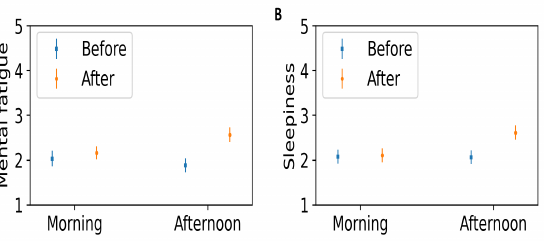
Figure 5. Self-reported measures recorded before and after the experiment, as a function of the time of day – (A) Mental fatigue and (B) Sleepiness. Error bars indicate standard